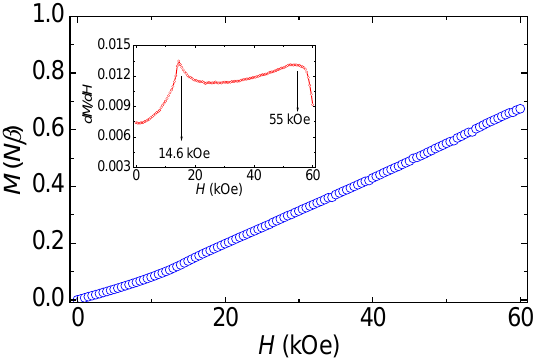
Figure 9. The isothermal magnetization of 2 at 2.0 K. The inset gives the derivation of M vs. H .